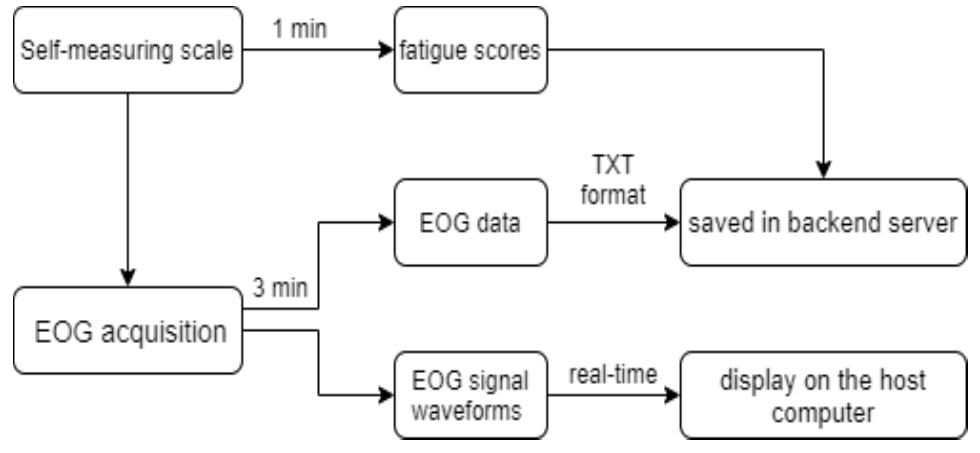
Figure 6. Eye fatigue experiment process.